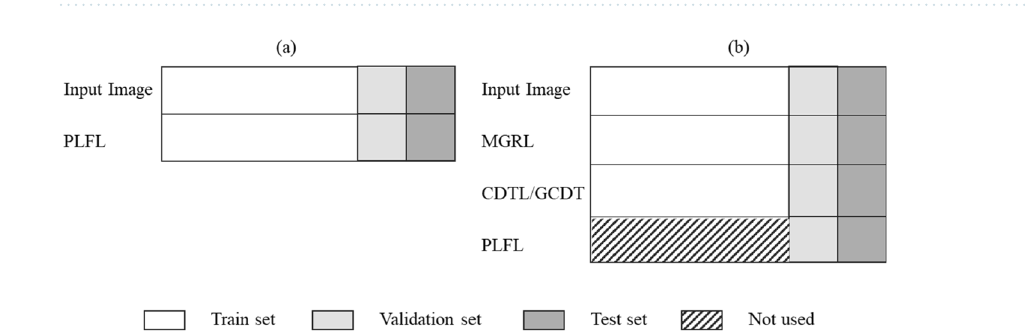
Figure 7. Distribution of data for conventional training and the proposed training method. ( a ) Data distribution in general neural network training. ( b ) Data distribution in the proposed method.